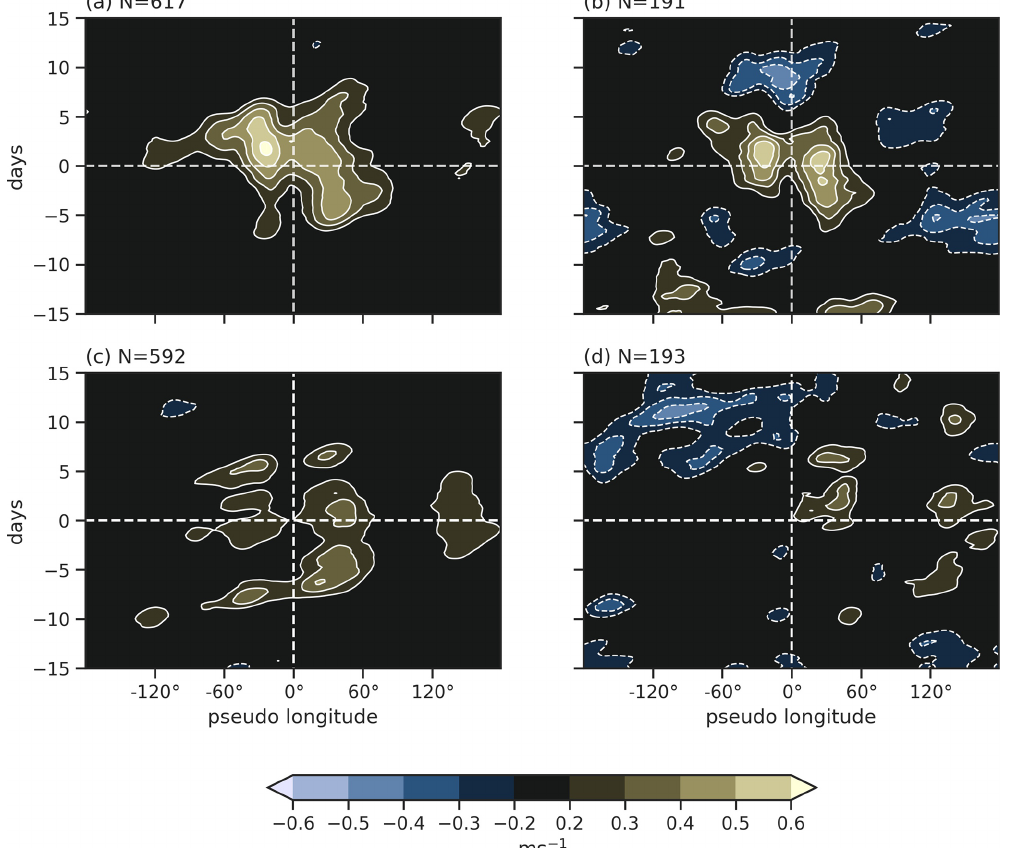
Figure E1. Time-lagged Hovmöller composites of R anomalies centred on the mean longitude and time of maximum amplitude of blocks located in the Pacific Ocean (180–60 ◦ W, 30–80 ◦ S) in panels (a) and (b) and Indian Ocean (60–180 ◦ E, 30–80 ◦ S) in panels (c) and (d) . Left column includes blocks for all seasons, and right column shows them for DJF. N denotes the number of blocks for each